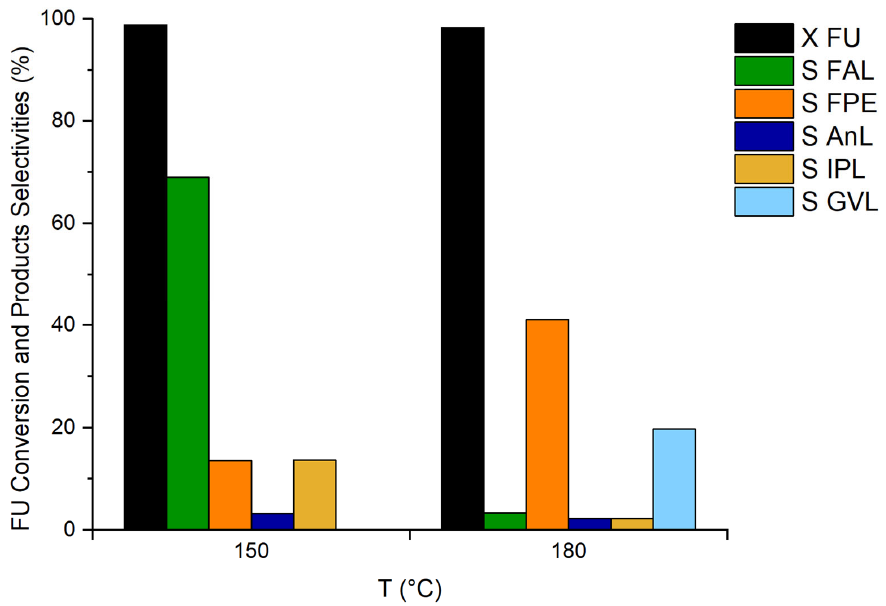
Figure 9. Furfural conversion and product selectivity trends as a function of reaction temperature (°C) using Ti/Zr/O (1:1). Reaction conditions: [FU] = 67 mM, τ = 10 min, m cat = 0.76 g.